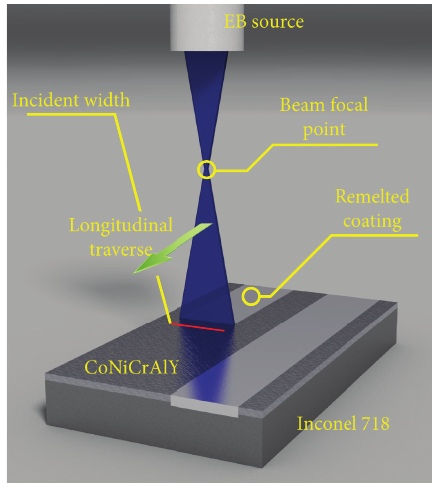
Figure 2: Schematics of EB surface